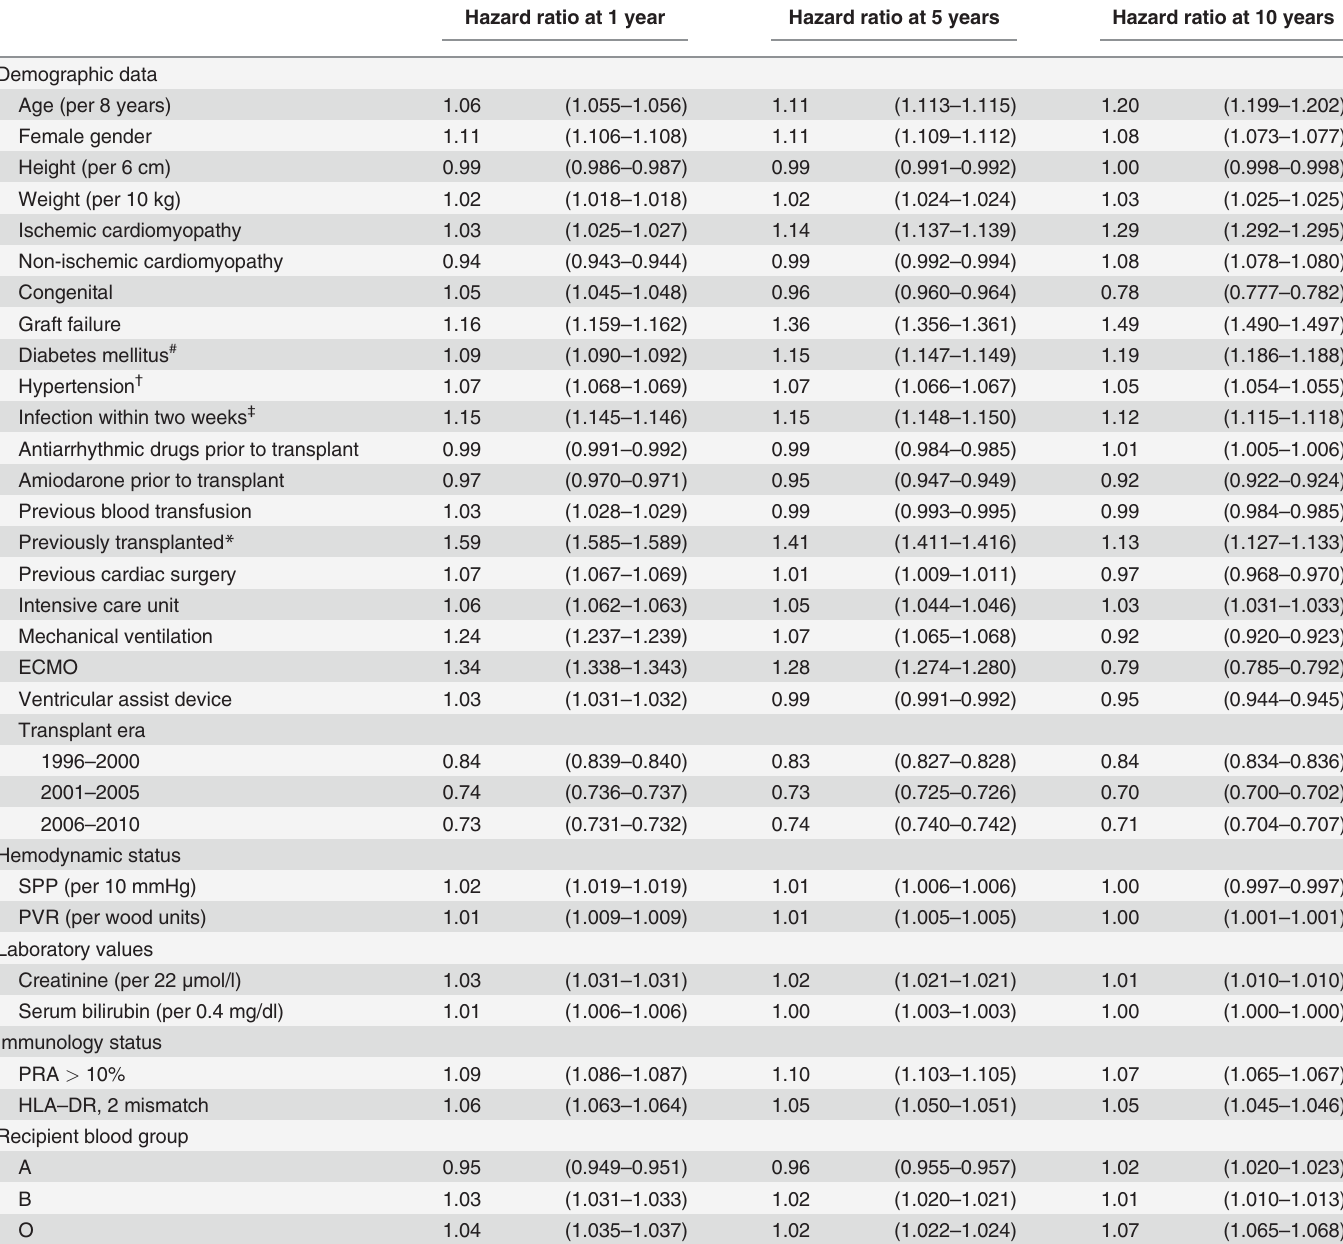
Table 3. Time-dependent hazard ratios for the 32 recipient risk variables included in the IHTSA model. Hazard ratio at 1